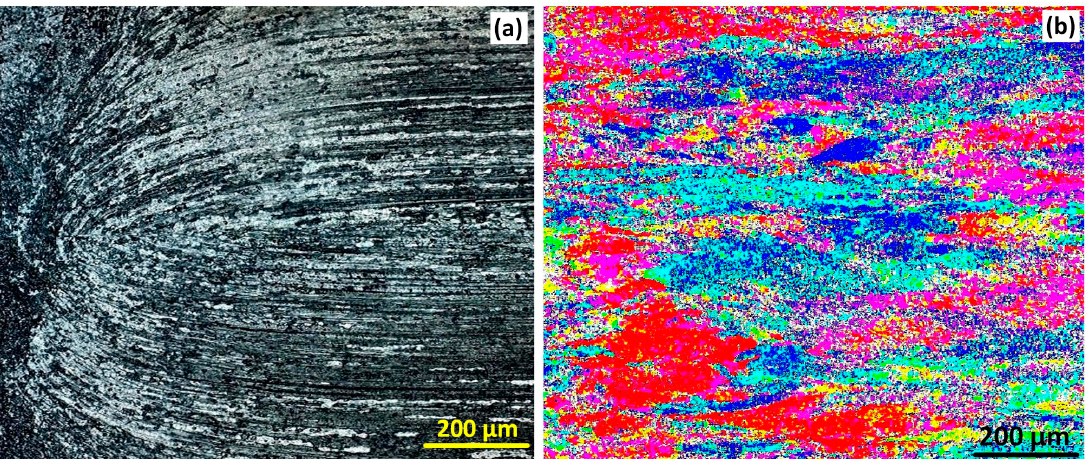
Figure 9. The microstructure of the RS Hourglass border, ( a ) Optical microscopy and ( b ) EBSD colour map.